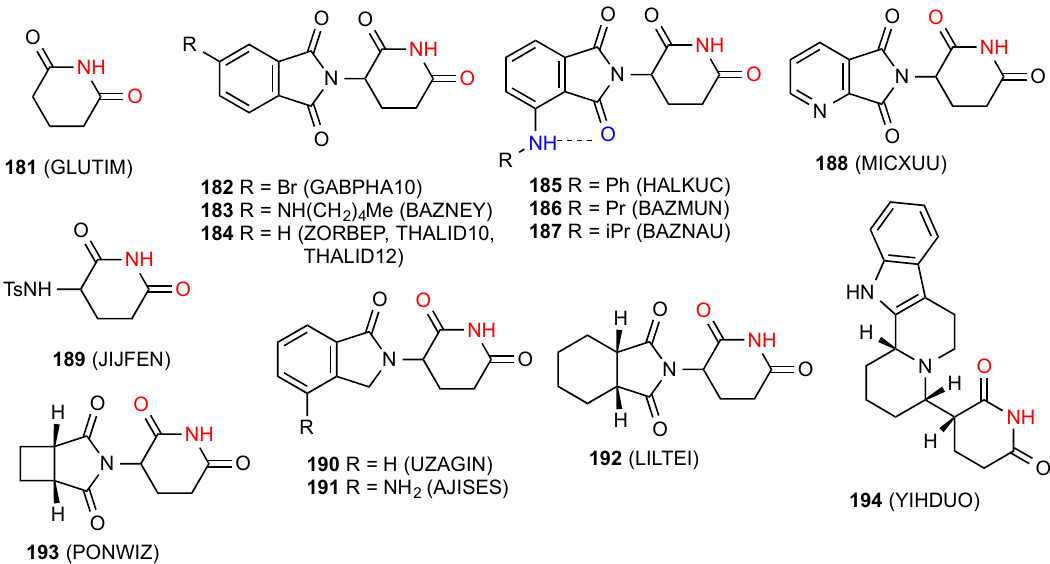
Figure 57. Glutarimide (pattern B ) and 3-monosubstituted glutarimides with pattern A structures.